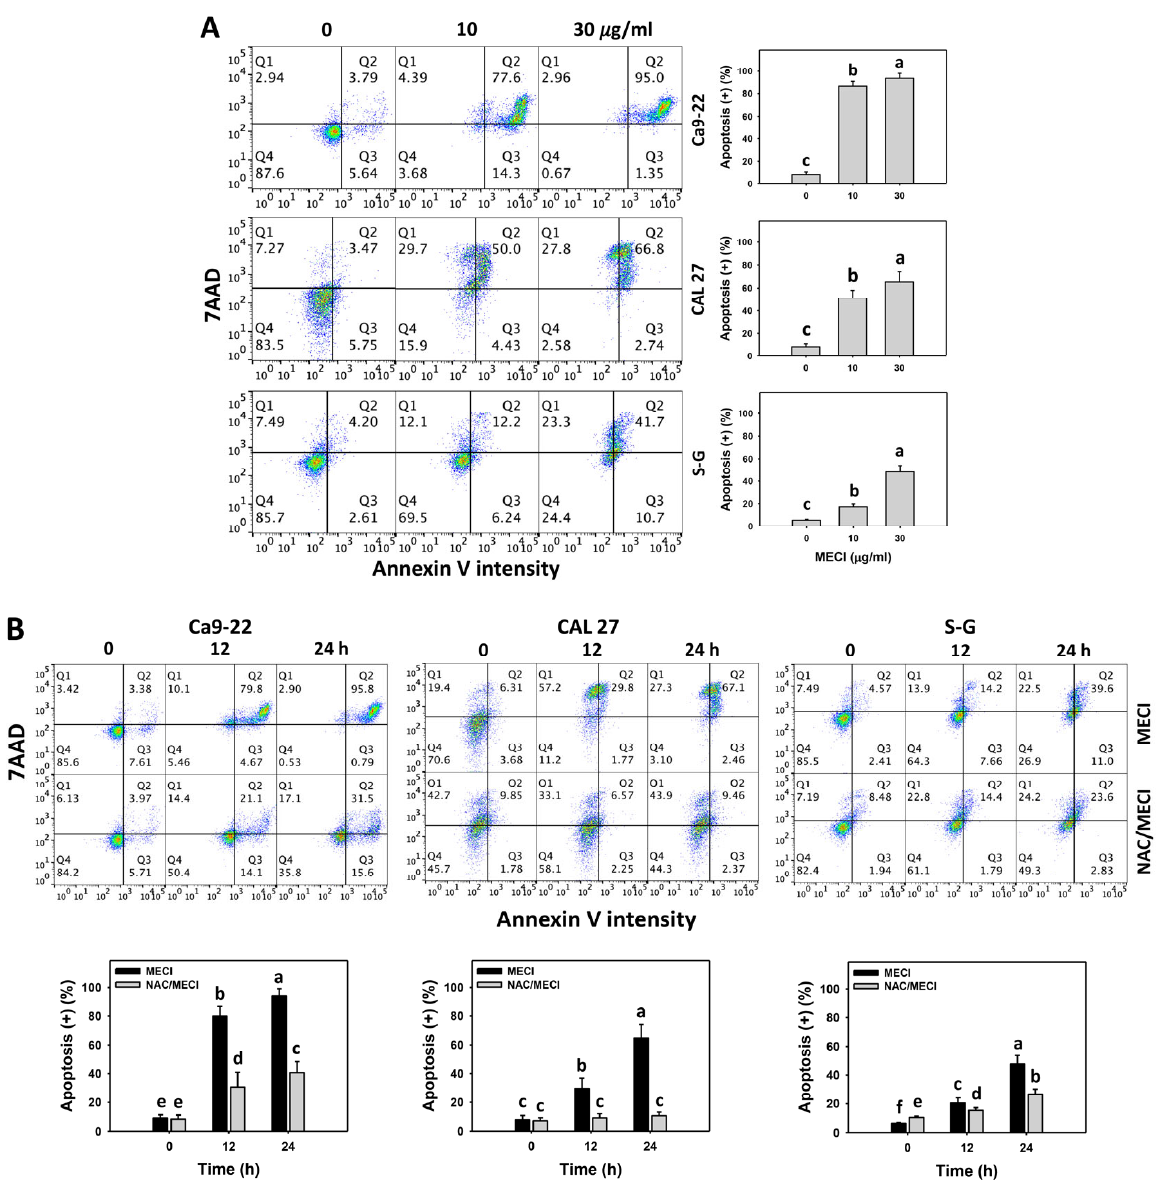
Figure 4. Annexin V-detected apoptosis. ( A ) Annexin V/7AAD. Except for S-G cells, others were oral cancer cells. After 24 h MECI incubation (0 (0.1% DMSO in the medium), 10, and 30 µ g/mL), cells were subjected to flow cytometry. Annexin V (+)/7AAD (+/ − ) spots were specified for apoptosis (+). ( B ) Impact of NAC on MECI-induced apoptosis changes to oral cancer cells. After pretreating with NAC, cells were post-treated with MECI (30 µ g/mL) for 0, 12, and 24 h. Data, mean ± SD ( n = 3). For the same cell line, columns showing non ‐ overlapping letters differ significantly ( p < 0.05).